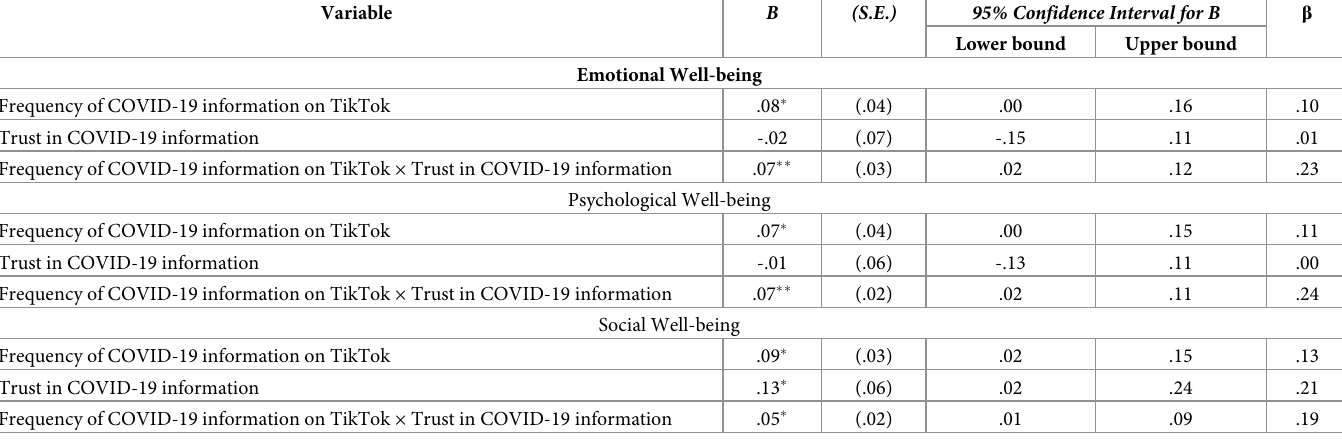
Table 3. Estimates for the main effects and interaction effects of frequency of COVID-19 information on TikTok and trust in COVID-19 information on well- being.